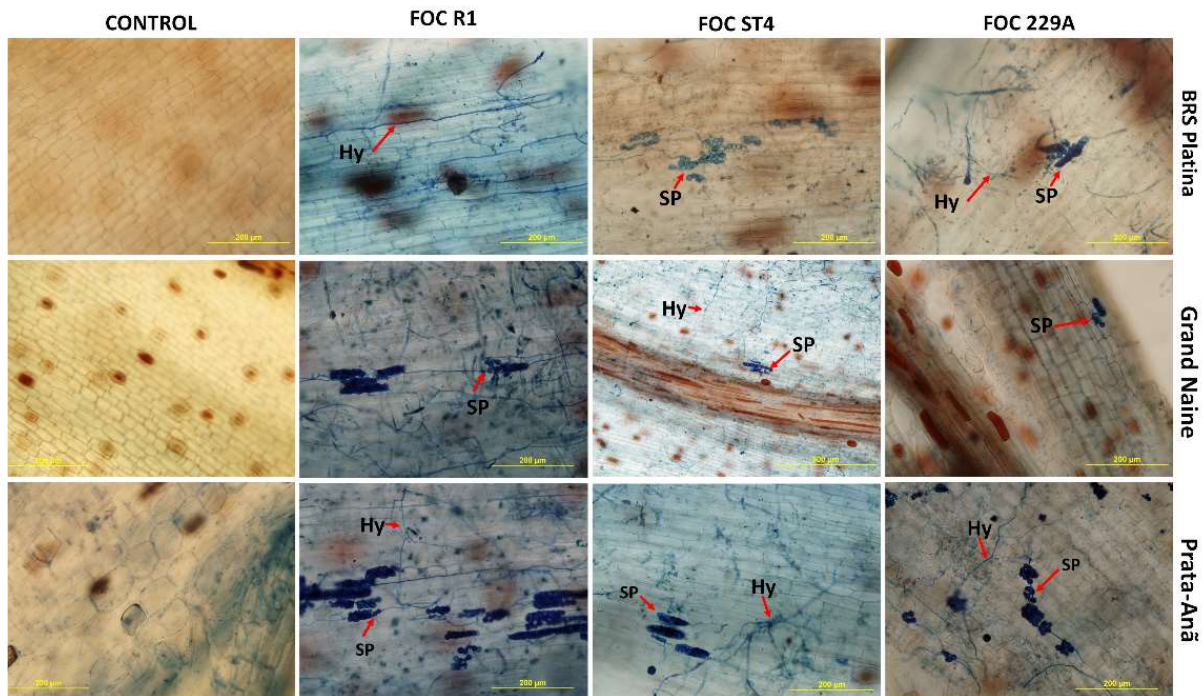
Figure 6. Root clarification and staining of fungal structures with trypan blue dye after infestation by different isolates of Fusarium oxysporum f. sp. cubense 90 days after inoculation. SP: spores; HY: hyphae. Red arrows indicate hyphae (Hy) and spores (SP). Foc: Fusarium oxysporum f. sp. cubense ; R1: race 1; ST4: subtropical race 4; bars = 200 μm.